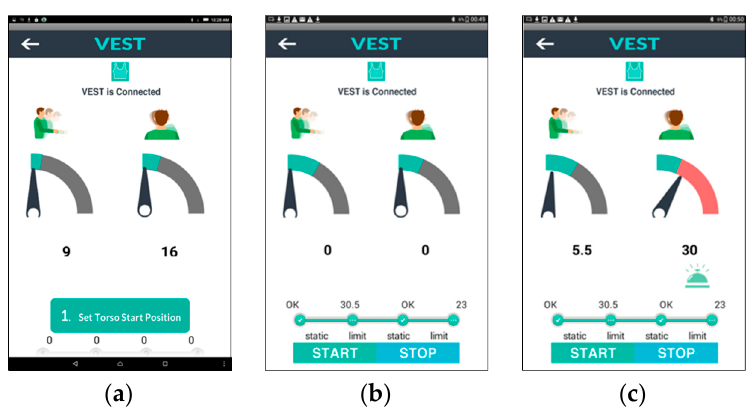
Figure 9. Interfaces design in different stages. ( a ) Automatically connected. ( b ) Set personalized value of start position and threshold. ( c ) Visual feedback when the shoulder value is over range .